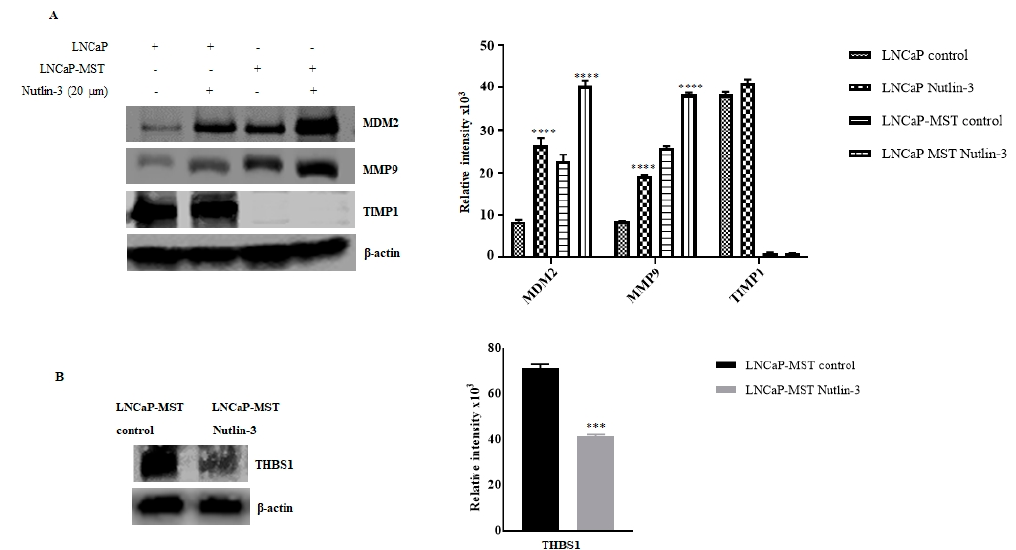
Figure 5. ( A ) Illustrates that the MDM2, MMP9 and TIMP1 protein expression in the LNCaP and LNCaP-MST cells after Nutlin-3 (20 µM) treatment (**** p < 0.0001). ( B ) Shows down-regulation of THBS1 protein after Nutlin-3 treatment (*** p < 0.001).